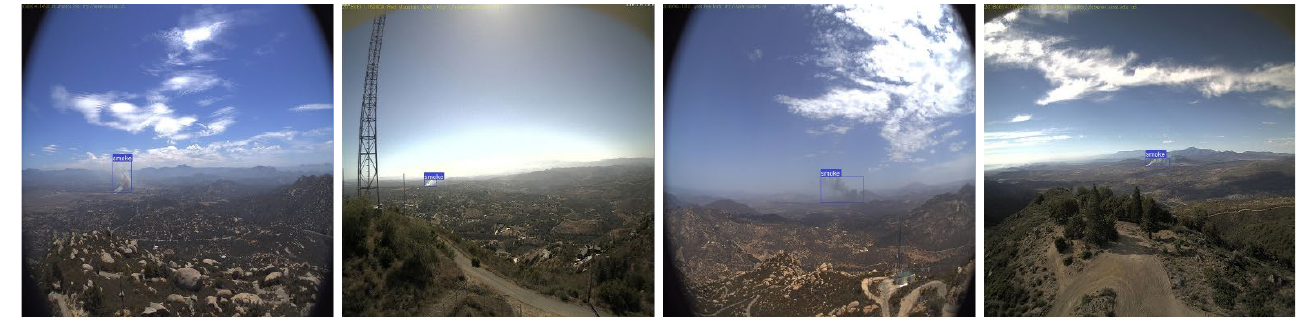
Figure 11. Examples of images of small-sized smoke for wildfire smoke detection dataset. Table 9. The proposed method versus other two-stage object detectors on the custom wildfire smoke dataset test-set. Improved YOLOv5m achieves results that are competitive with two-stage object detectors.